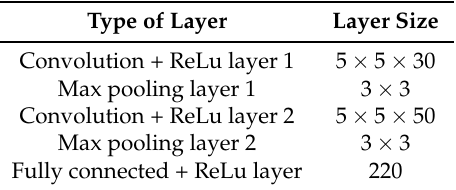
Table 4. The DNN architecture for the MNIST dataset used in the experiments (ReLu stands for Rectified Linear